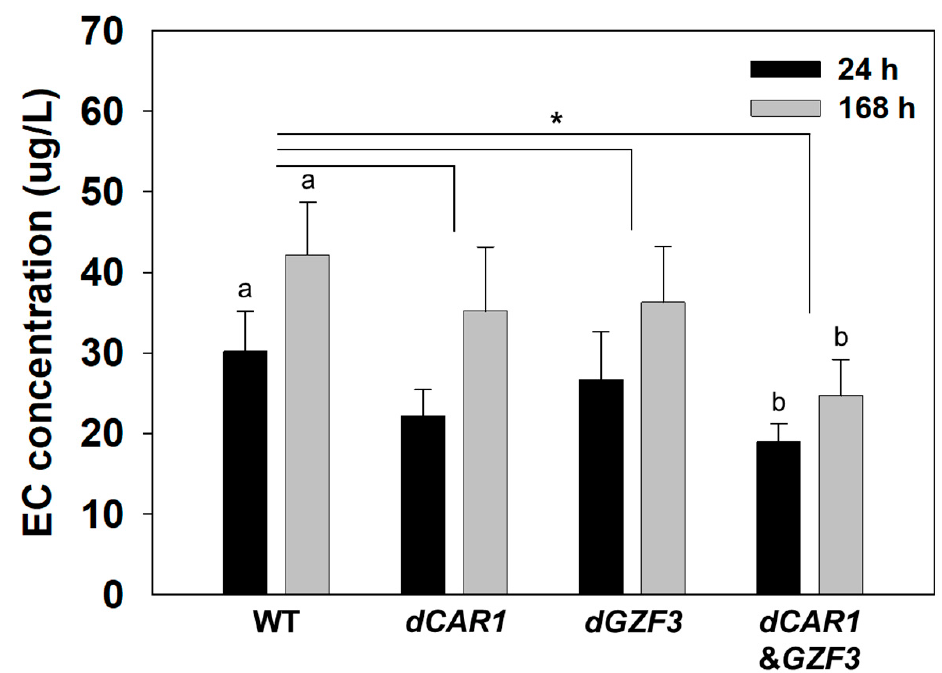
Figure 5. Comparison of EC concentrations in Makgeolli products brewed by the wild-type S. cerevisiae GRL6, and the engineered S. cerevisiae dCAR1 , dGZF3 , and dCAR1 & GZF3 strains. Data were analyzed using One-way ANOVA to determine whether the EC concentrations in Makgeolli by the engineered strains are any statistically significant differences (a and b) when compared to the wild-type strain at each time point (24 h or 168 h). * means p < 0.05.